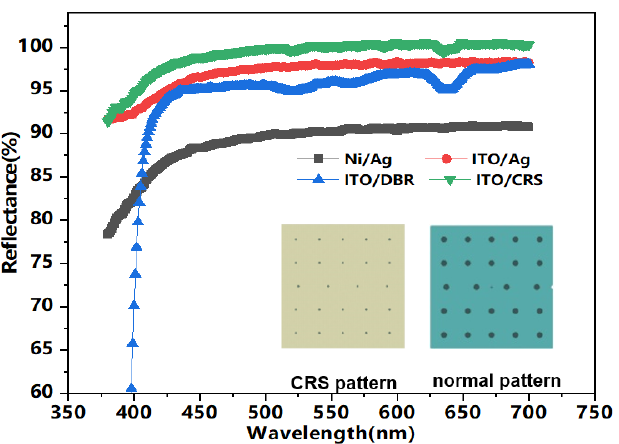
Figure 2. Reflectance of Ni/Ag, ITO/Ag, ITO/DBR, and ITO/CRS films (inset: normal pattern and CRS pattern).